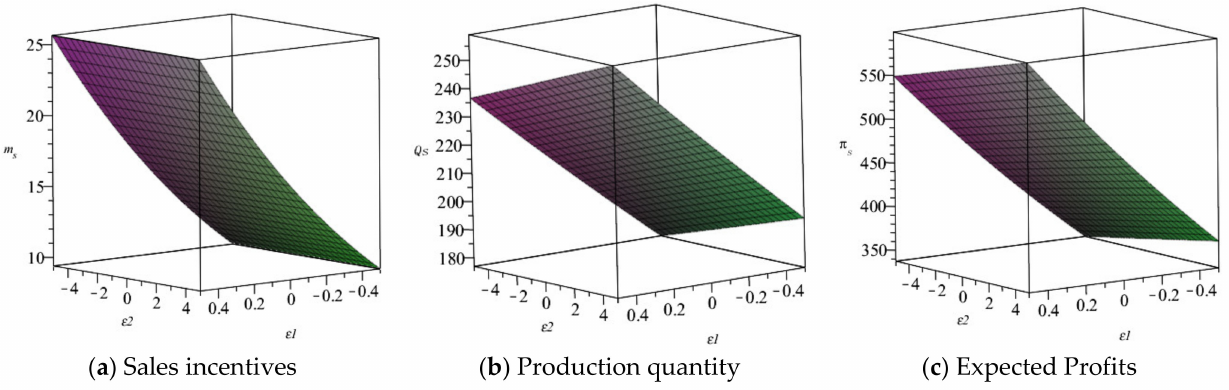
Figure 6. Joint effect of price and demand forecasting errors on optimal sales incentives, production quantity, and expected profit. Table 7. The parametric values of the sequential optimization decision model when the prediction errors of refined oil price and demand are used.